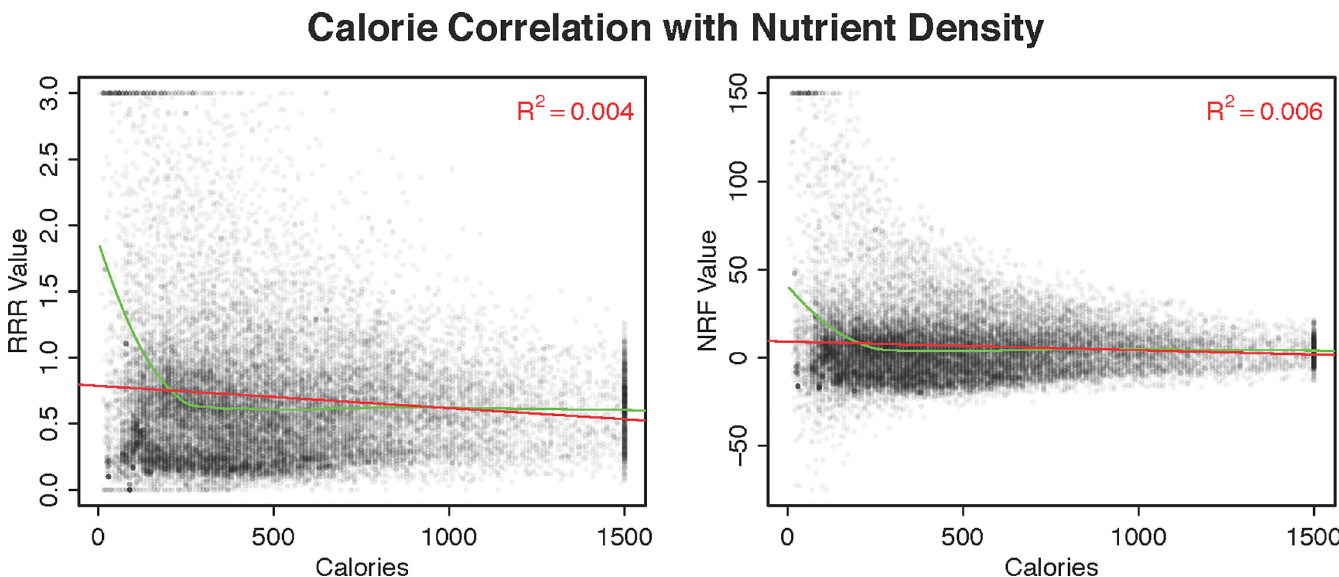
Fig 2. Correlation between calories on the x -axes and nutrient scores on the y -axes. Each point represents a brand food item. The left panel displays data for RRR values and the right panel displays data with NRF (per 100 kcal) values. The red line plots the raw regression line (with corresponding R 2 value in top right corner) and the green line plots a loess fit. For visibility, data points are randomly jittered and truncated for RRR values above 3, NRF values above 150 and below -75, and calories above 1,500.